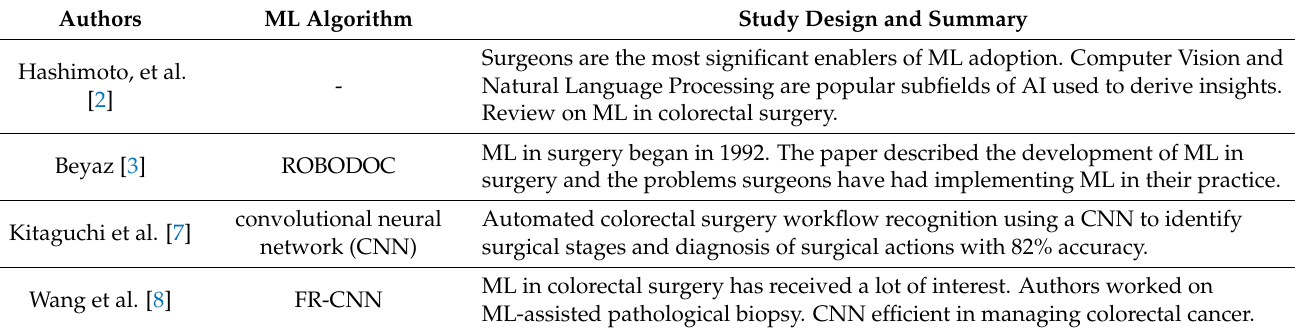
Table 1. Summary of included articles.